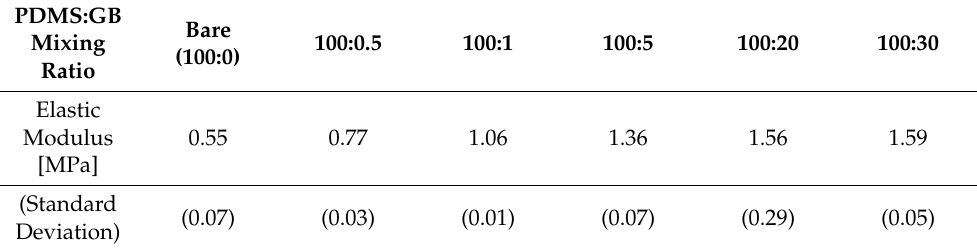
Table 4. Elastic modulus values of specimens with respect to PDMS:GB mixing ratio.